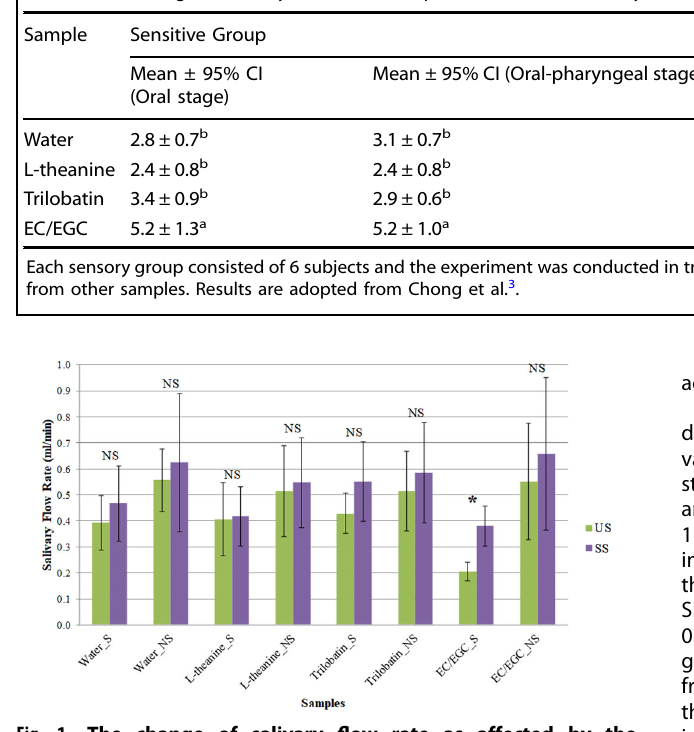
Fig. 1 The change of salivary fl ow rate as affected by the consumption of samples in sensitive and nonsensitive group. (US and SS are the unstimulated and stimulated saliva before and after the consumption of sample, respectively; S and NS denote Sensitive and Nonsensitive group, respectively. * and NS indicate signi fi cant and not signi fi cant difference within each sample of the particular sensory group, respectively. The error bars represent 95% con- fi dence